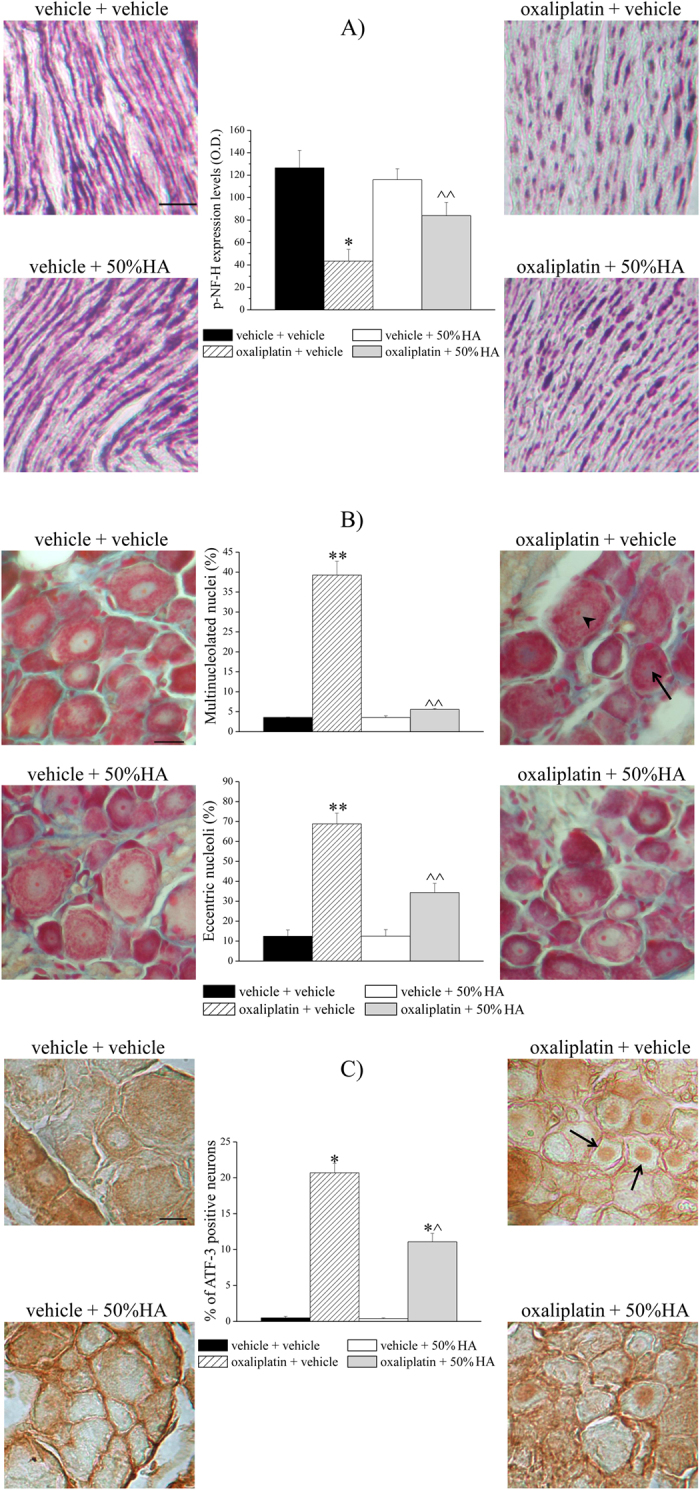
Effect of 50%HA on oxaliplatin-dependent damages of the peripheral nervous system.The protective effect of 50%HA was evaluated on the sciatic nerve and in DRGs of treated animals on day 21. (A) p-NF-H expression levels in sciatic nerve. A representative immunohistochemical staining for p-NF-H in 10 μm longitudinal sciatic nerve sections is shown. For all images the scale bar = 10 μm and the original magnification was 20X. Bars show quantitative evaluation of neurofilament expression levels obtained by densitometric analysis. (B) Morphological aspects of DRG nuclei and nucleoli. The protective effect of repeated administrations of 50%HA was evaluated on oxaliplatin-damaged DRGs on day 21. Five μm DRG sections were stained by the Azan-Mallory method. Light micrographs (for all images: scale bar = 5 μm, original magnification 40X) were analyzed by measuring the occurrence of eccentric nucleoli (black arrowhead) and multinucleolated neurons (black arrow). Histograms show the incidence of nuclear and nucleolar pathological features in the absence (black bars) and in the presence of 50%HA (grey bars). (C) ATF-3 expression in L4-L5 DRGs. Typical immunohistochemistry images of ATF-3 expression in the DRG following oxaliplatin (oxaliplatin + vehicle) and oxaliplatin combined with 50%HA (oxaliplatin + 50%HA) treatments (day 21). ATF-3 staining is clearly punctuate and confined to the nucleus, shown as intense compact staining in brown (black arrows). The percentage of ATF-3-positive neurons in L4 and L5 DRGs is shown in the histogram. All images: scale bar = 10 μm, original magnification 20X. Each value represents the mean ± SEM of 6 rats per group, performed in two different experimental sets. *P < 0.05 versus vehicle + vehicle; ^P < 0.05 and ^^P < 0.01 versus oxaliplatin + vehicle.